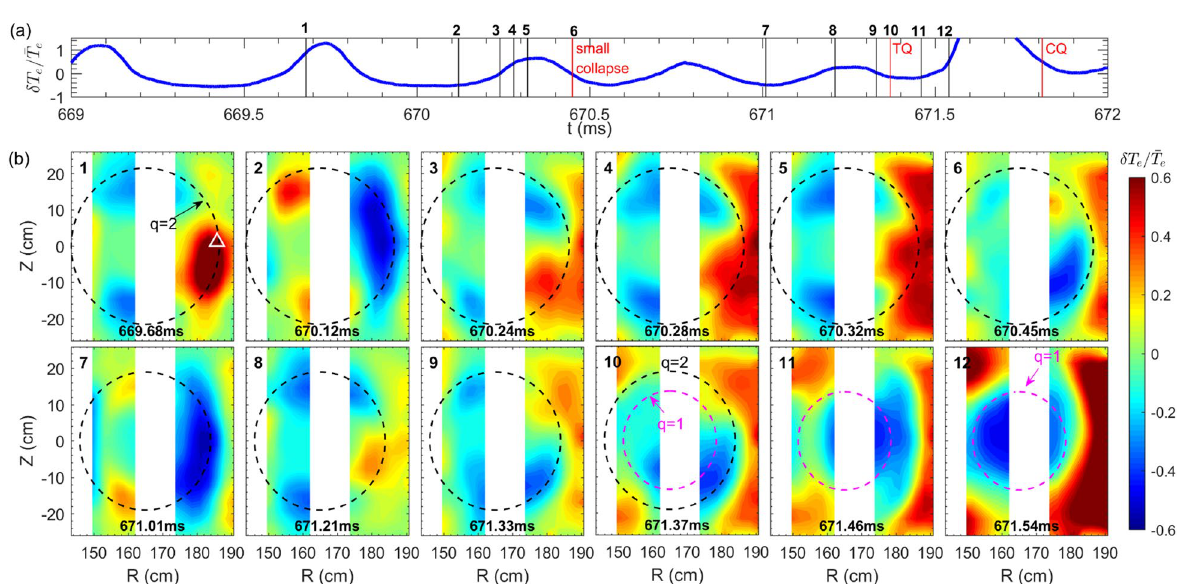
Figure 7. Time evolutions of the MHD instability behaviors towards the plasma disruption: ( a ) relative temperature perturbation ( δ T e / ¯ T e ) measured at R = 185.9 cm and Z = 1.13 cm (marked by the white triangle in the first image of Fig. 7b). The onsets of small collapse, TQ and CQ are denoted by vertical red lines. ( b ) ECE images taken at twelves time points marked by vertical lines in Fig. 7a. The q = 2 and q = 1 surfaces are illustrated by black and purple dashed circles, respectively